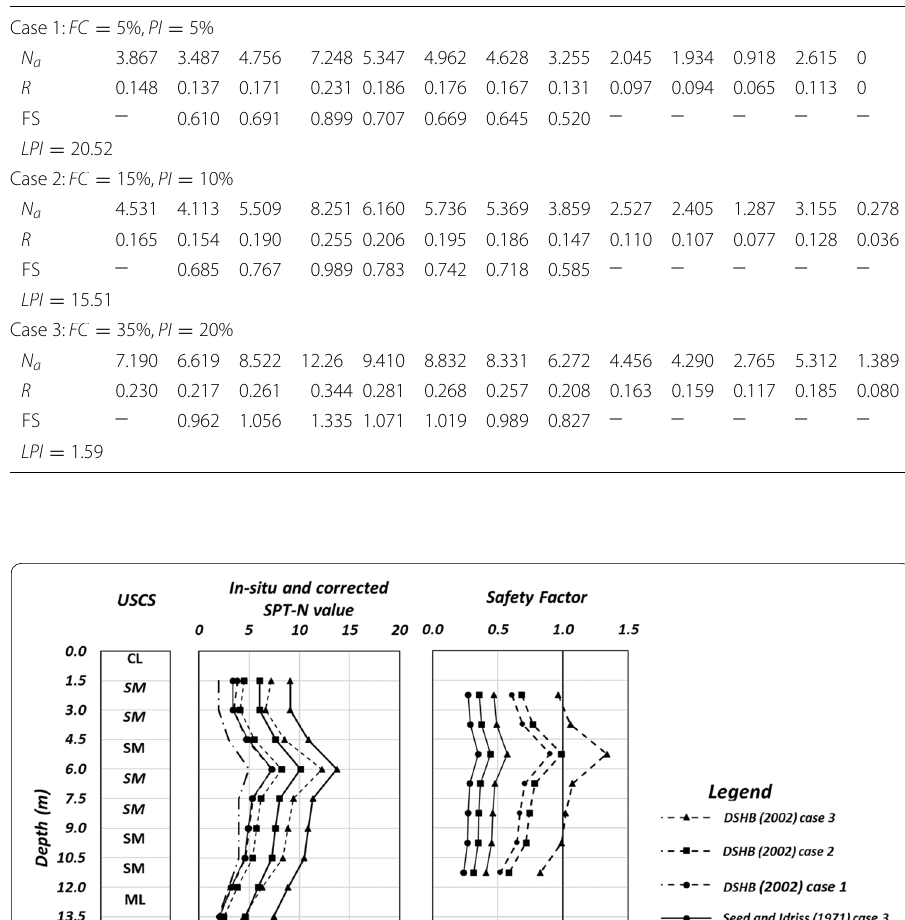
Table 4 Calculation details of LPI through DSHB [8] method for borehole B-25 Depth ( m ) 1.5